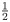
Metabolic pathway of menthol in rats and in human.This pathway is an adaptation from Yamaguchi, Caldwell, & Farmer [17], Madyastha & Sirvastan [18] and Hiki et al. [19]. Red, Green, and Blue numbers indicate that menthol metabolites were found in both rats and human, only in rats, and only in human respectively. Gray and Black numbers indicate menthol metabolites proposed by previous experiments and by this paper respectively. Arrows to the right and arrows upward indicate oxidation reactions + 12 O2 and–H2 respectively. Downward arrows indicate conjugation with sulfate. Dashed arrows indicate reactions of four-membered ring metabolites. Diagonal arrows toward top left indicate dehydration reaction. Main pathways are shown on the left and pathways containing glucuronide metabolites with similar possible connections are shown on the right. Lists of compounds and reactions are provided in S1 Table and Fig 3, respectively.